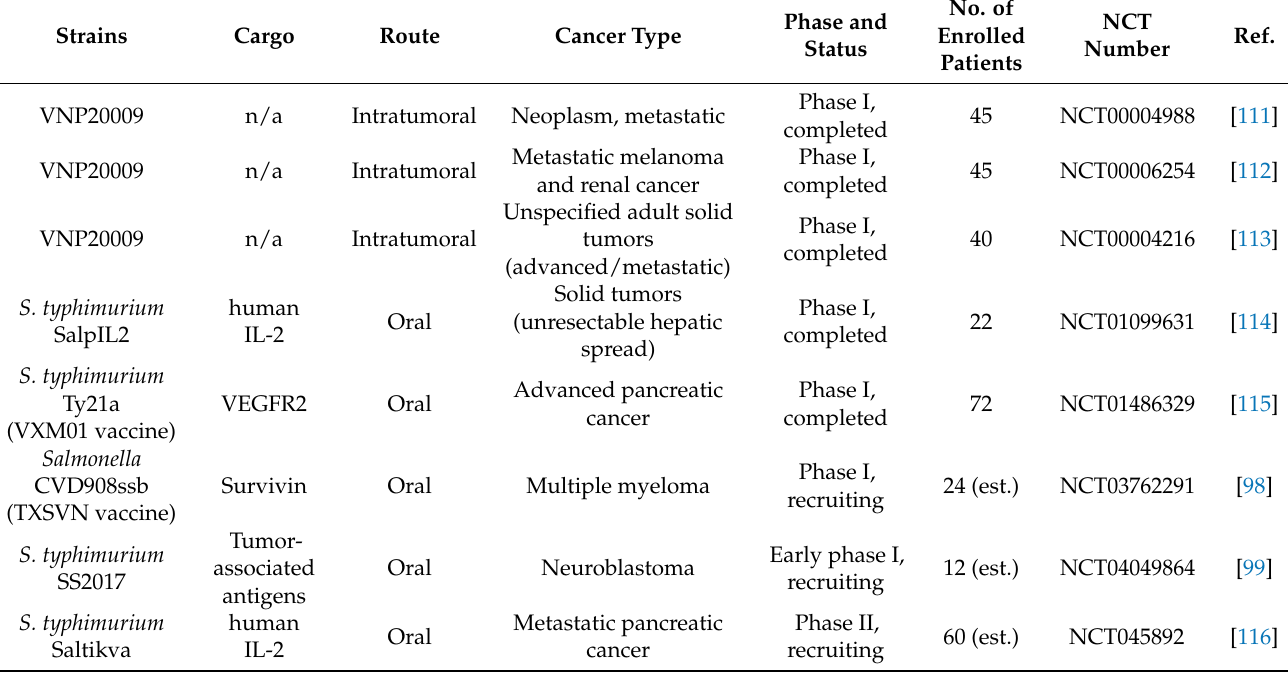
Table 3. Previous and ongoing clinical trials for Salmonella -based cancer